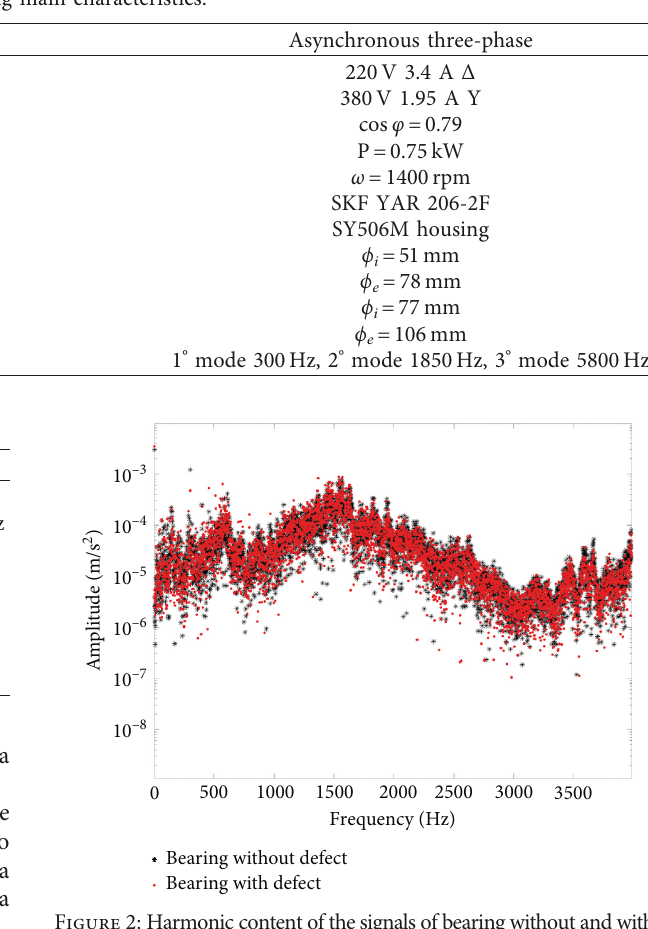
Table 1: Test rig main characteristics.